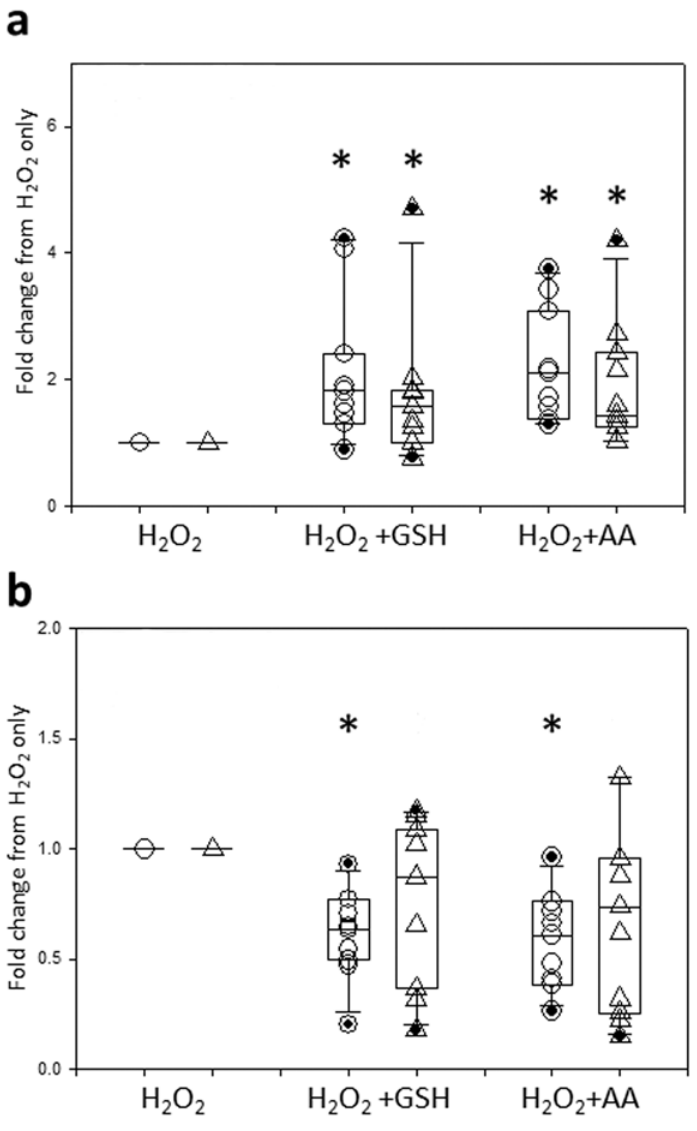
Fig 4. Ability of GSH and AA to protect against H 2 O 2 -induced cell death. PBEC obtained from non- asthmatic or asthmatic donors were treated for 24h with 400 μ M H 2 O 2 alone or in the presence of GSH (1mM) or AA (250nM). Changes in cell viability (a) and EA (b) were then evaluated with AxV staining. The results are displayed as a box plot showing median, interquartile range and 5 – 95% confidence intervals of fold changes from H 2 O 2 alone for PBECs from 10 non-asthmatic ( (cid:1) ) and 10 asthmatic ( Δ ) donors. * = p < 0.02 according to Wilcoxon Signed Rank tests comparing antioxidants with H 2 O 2 only. There was no statistical difference comparing antioxidants treatment between PBECs from non-asthmatic or asthmatic donors according to a Mann Whitney U test.